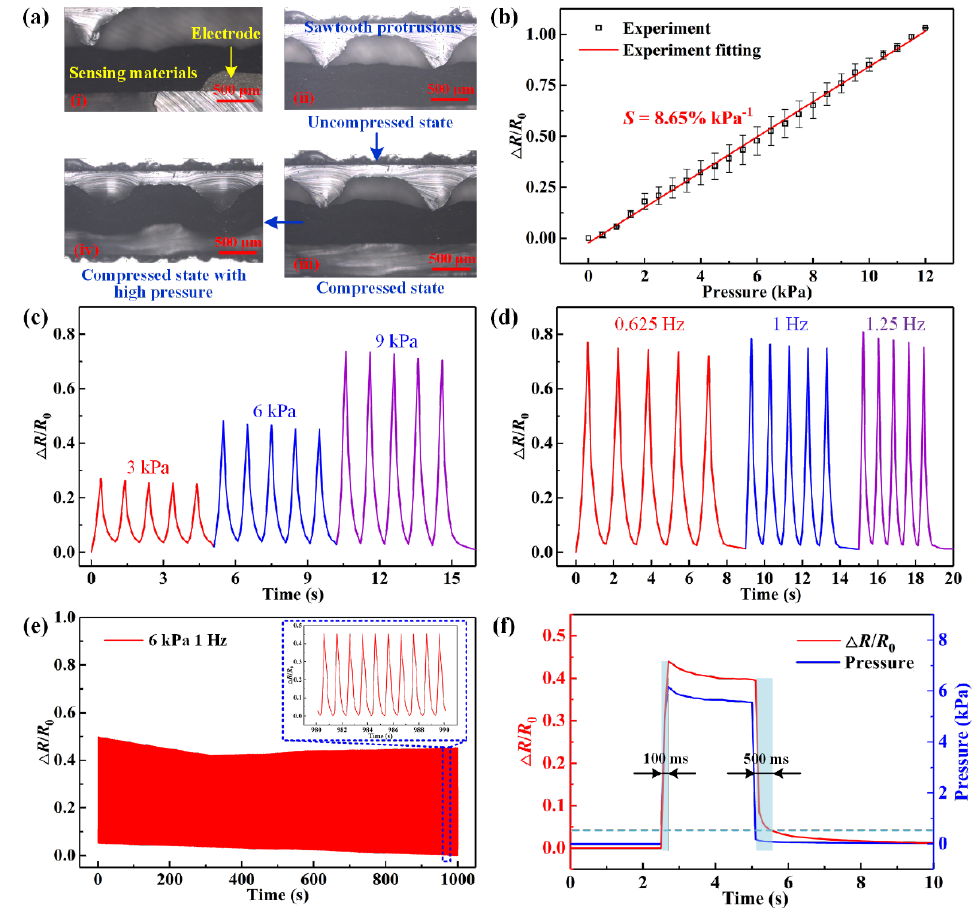
Figure 4. Characterization results of the wearable pulse detection device: ( a ) optical images of cross- section view of the device when examined using a laser confocal microscope; ( b ) pressure sensing sensitivity of the pulse detection device; ( c – e ) cyclic tests under different loading pressures, different frequencies, and multiple cycles, respectively; ( f ) response of the device under steady pressure